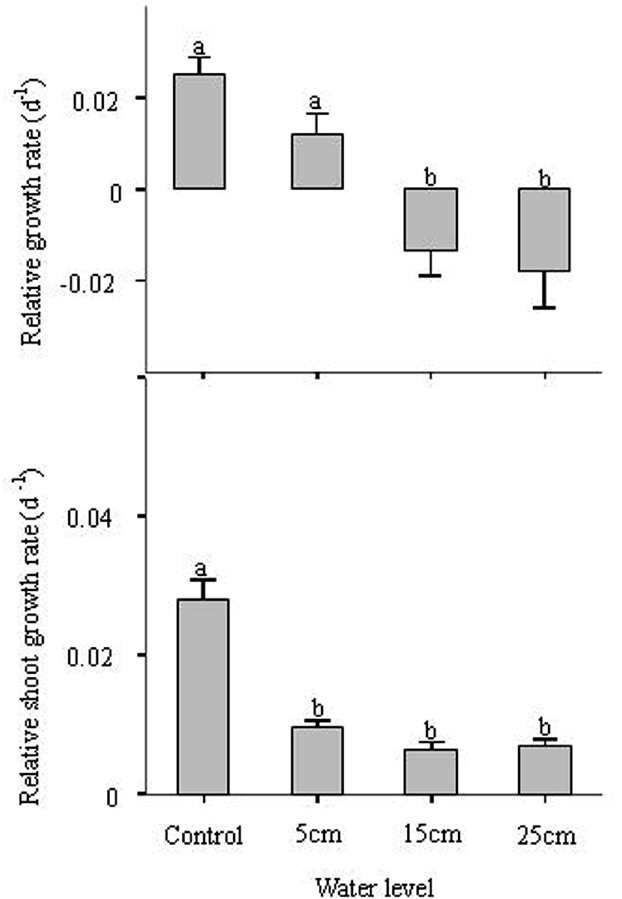
Fig 4. Relative growth rate and relative shoot growth rate of Carex schmidtii in different treatments (one control: 0 cm water level, and three submerged conditions: 5 cm, 15 cm, and 25 cm water level). Different letters indicate significant differences among treatments ( P <